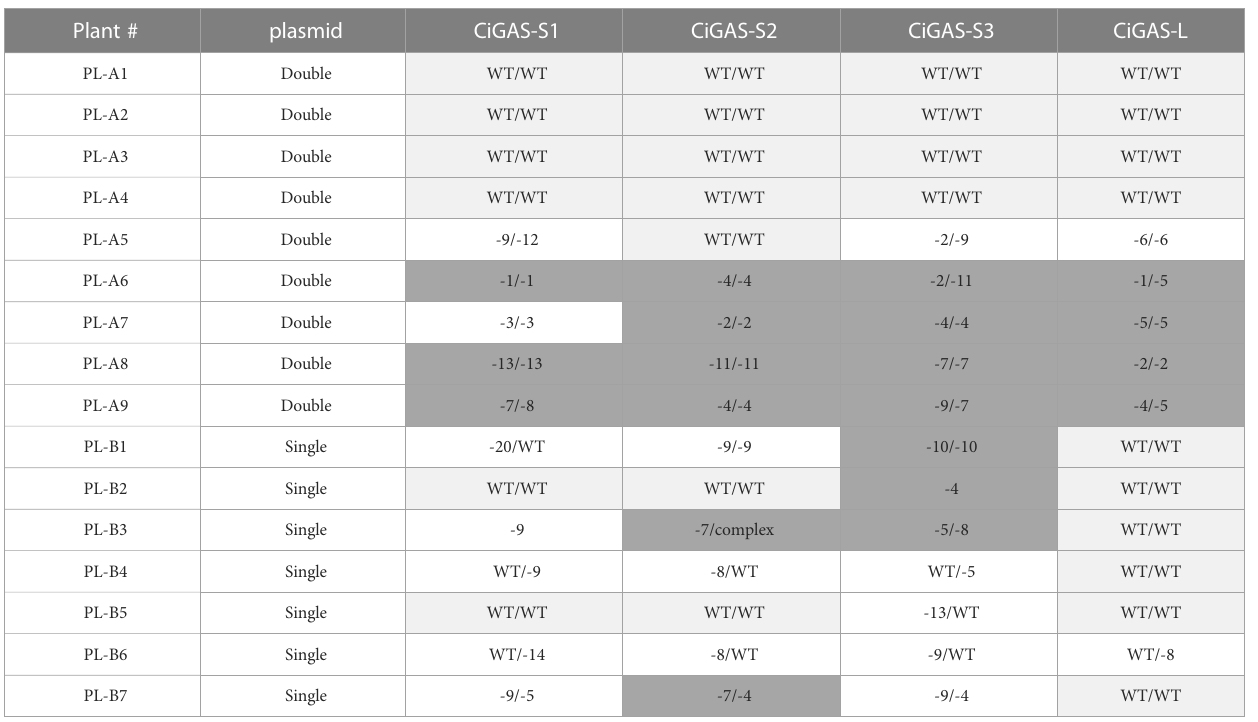
TABLE 2 CiGAS genotype of the plants regenerated from protoplasts transfected with